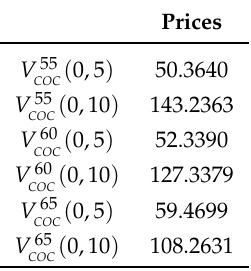
Table 8. The prices of the different individual S-forward contracts under the COC approach.